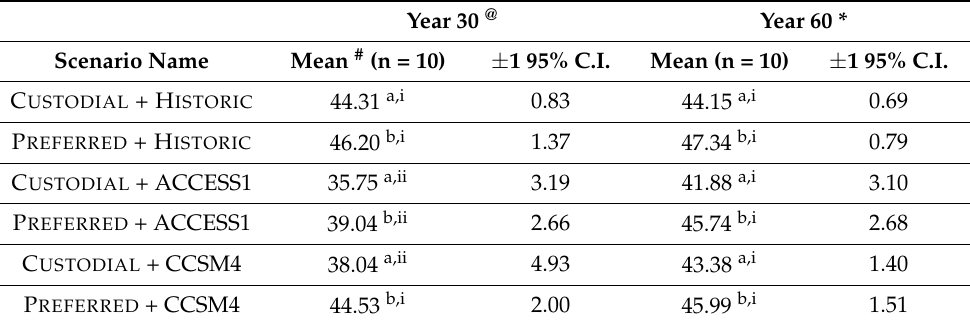
Table 9. Average habitat suitability for UPD in the Black Mountains. Habitat suitability scales from 0% to 100%. Average habitat suitability for year 0 of simulation was 48.4%. Difference between means was analyzed using a 2 × 3 factorial analysis of variance (ANOVA; 2 = management levels, 3 = climate levels). Degrees of freedom (df) for management, climate, interaction factors, and error, respectively, were (2 − 1) = 1, (3 − 1) = 2, (2 − 1) × (3 − 1) = 2, and 2 × 3 × (10 replicates − 1) =